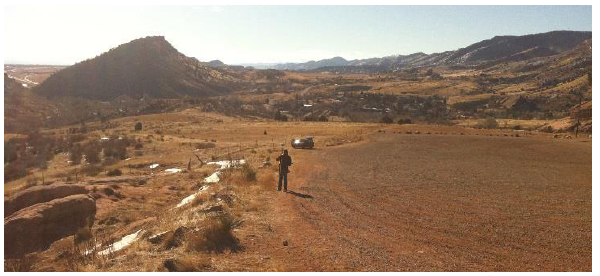
Figure 7. Dynamic topography within the test field